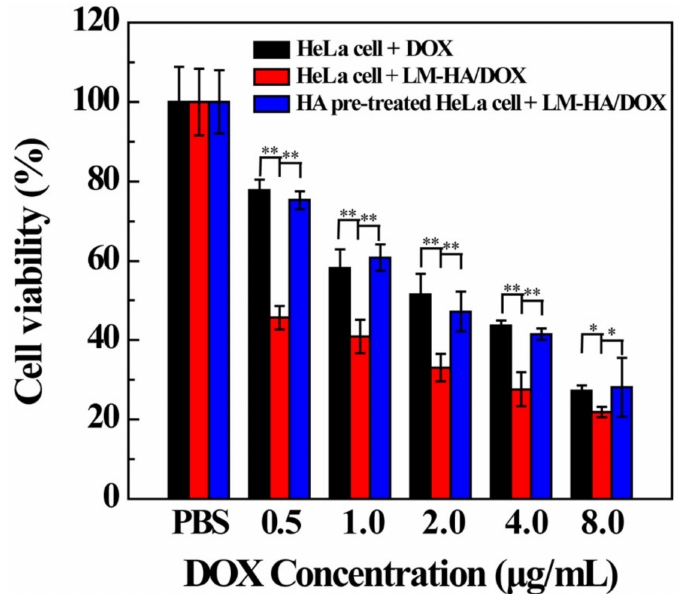
Figure 7. MTT viability assay of HeLa cells and HA pre-treated HeLa cells treated with free DOX and LM-HA/DOX nanocomposites for 24 h with different DOX